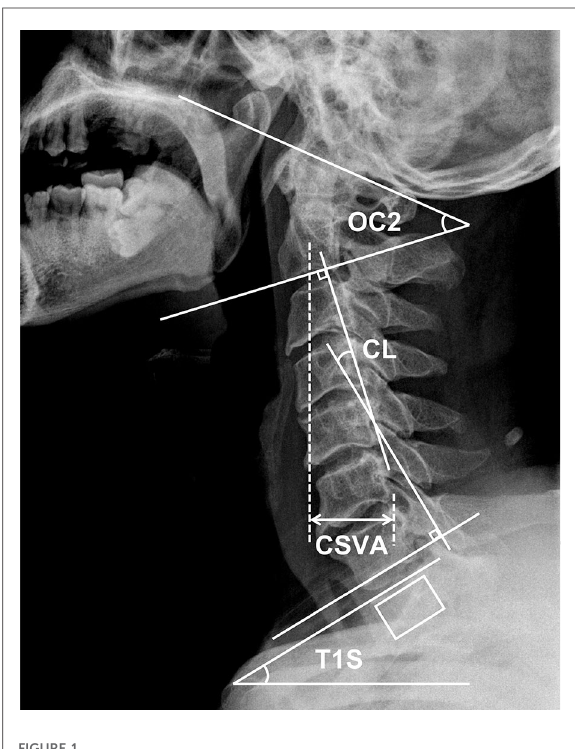
FIGURE 1 Measurements of cervical sagittal parameters utilized in this